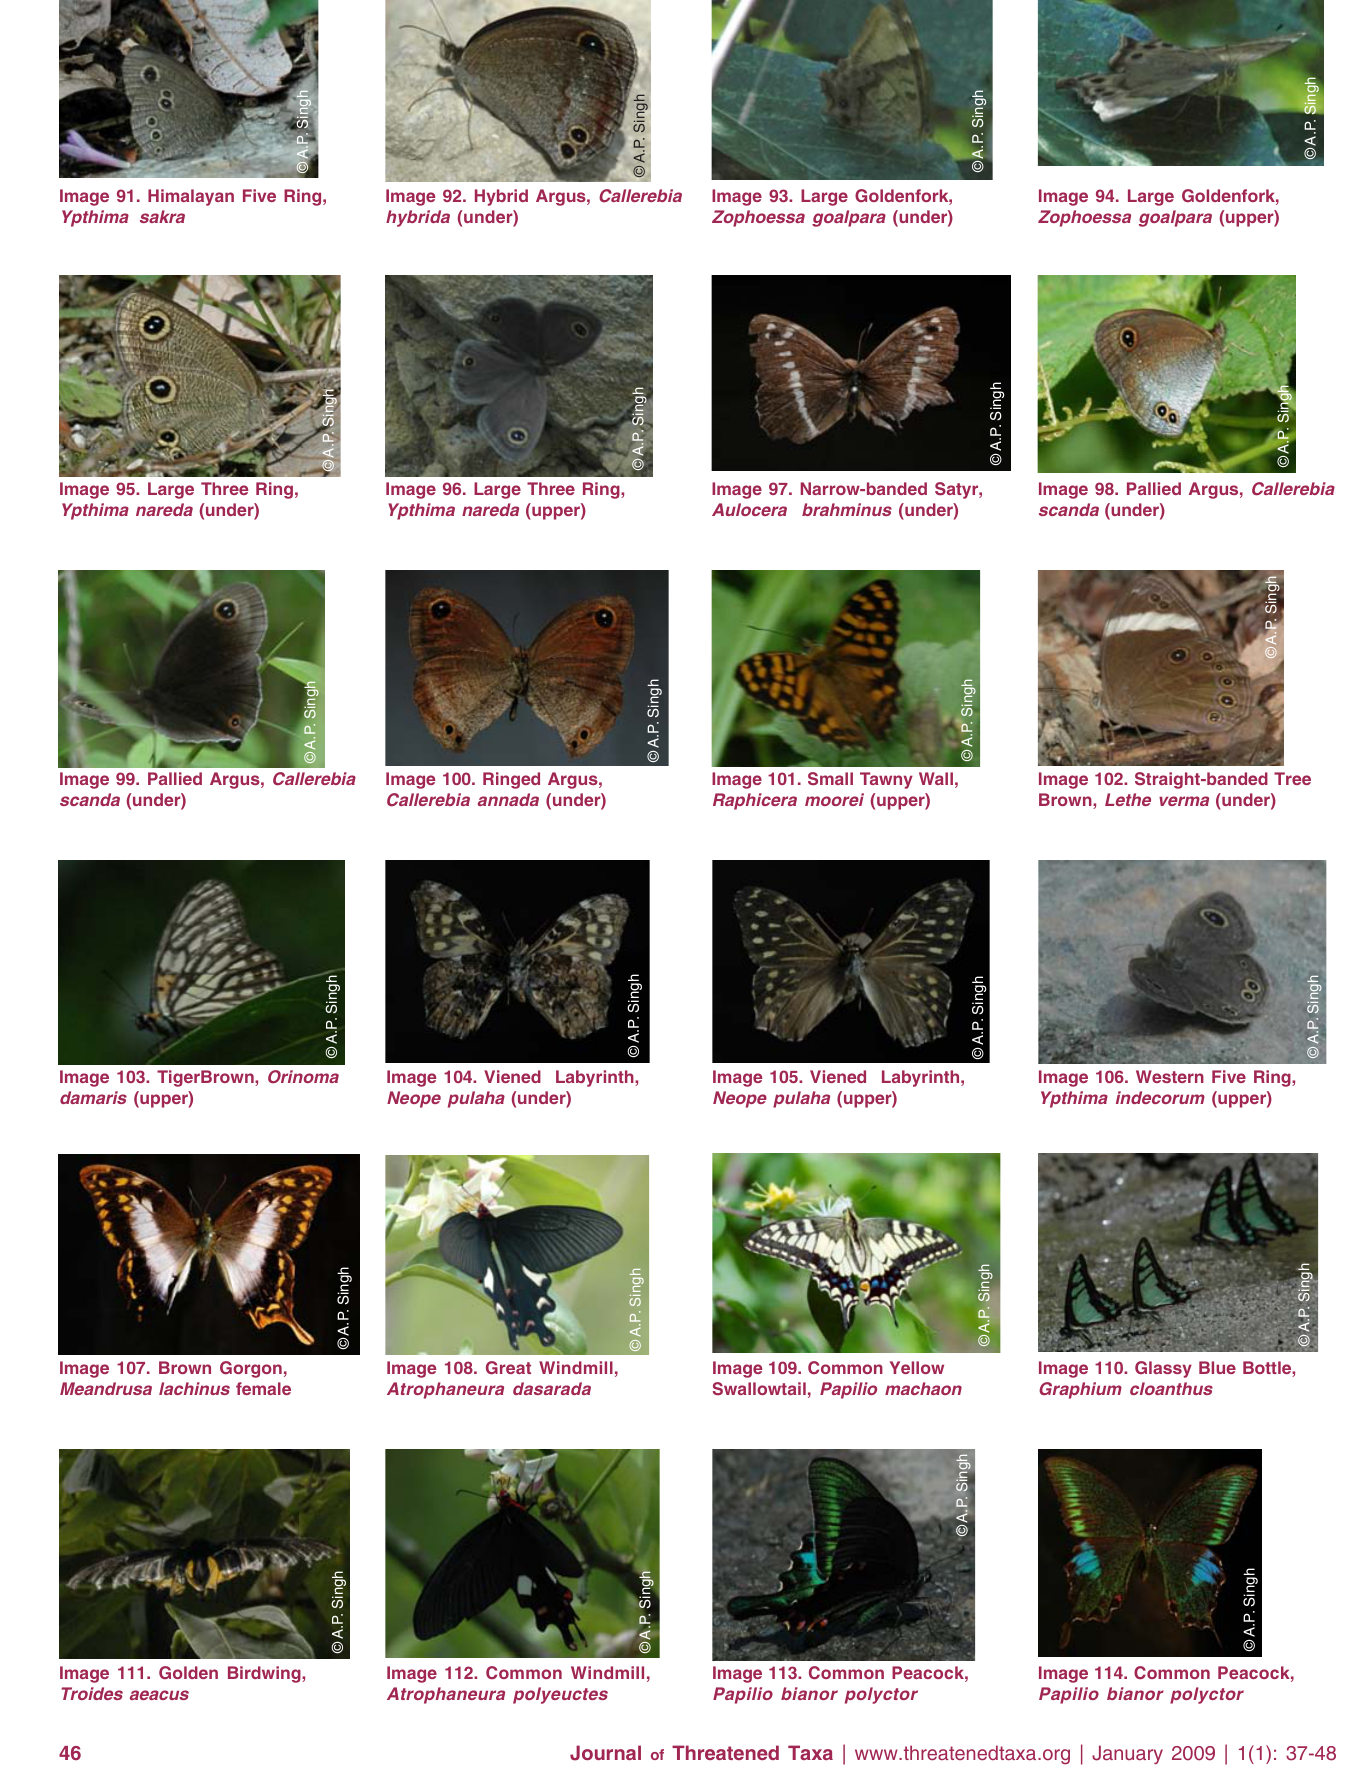
Image 111. Golden Birdwing, Troides aeacus